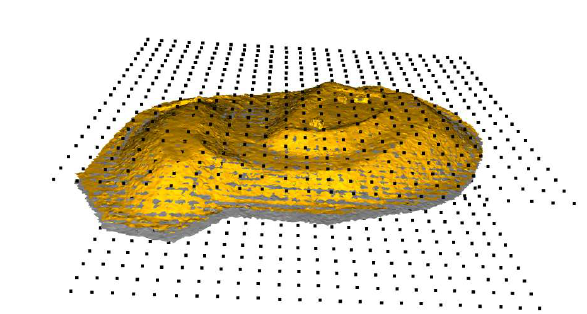
Figure 14: Section of two meshes in Gregorius to test the influence of grid cell size to accuracy, here the grid size is 1m.